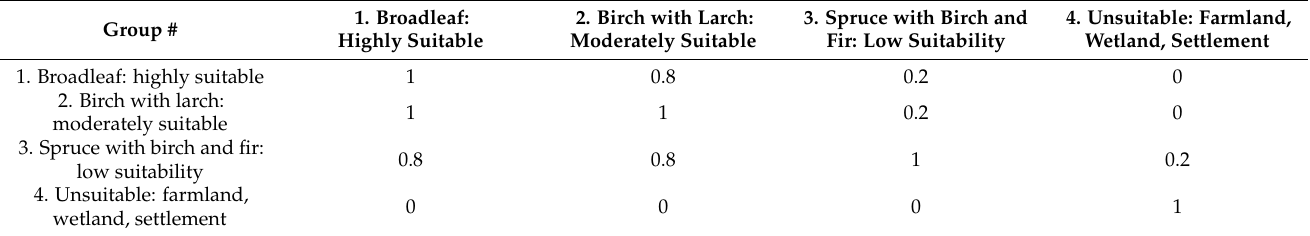
Table A4. Neighborhood matrix between groups of habitats used for calculation of similarity index.